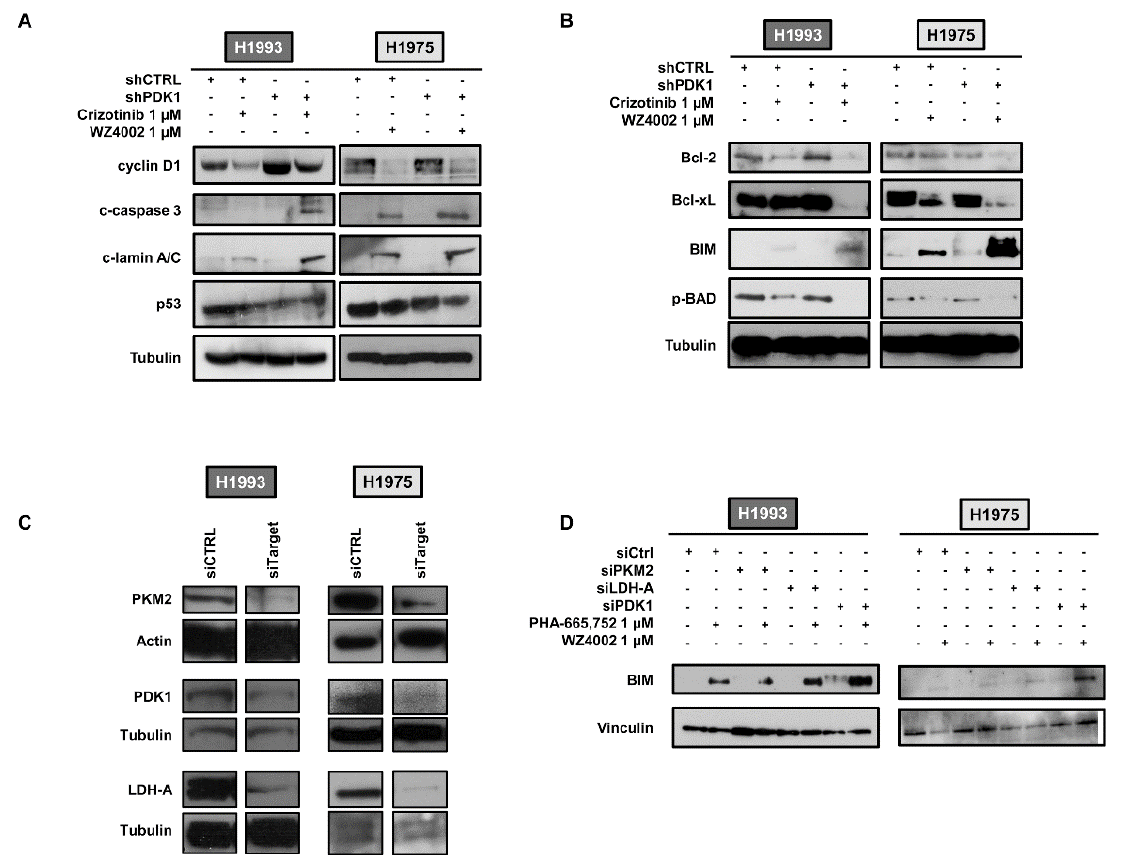
Figure 3. Combined effects of PDK1 knockdown and TKI treatment on cyclin D1, apoptotic markers and levels of Bcl-2 family members. ( A,B ) Western blot analysis of whole cell lysates from shCTRL and shPDK1 H1993 and H1975 cells in basal conditions and after treatment with crizotinib or WZ4002, respectively, showing levels of cyclin D1, cleaved caspase 3, cleaved lamin a/c and p53 ( A ) along with levels of Bcl-2 family members ( B ). ( C ) LDH-A, PKM2 or PDK1 silencing in H1993 and H1975 cells by siRNA and levels of the target protein. ( D ) Representative Western blots showing BIM levels in siRNA transfected H1993 and H1975 cells in basal conditions and after treatment with TKIs. Tubulin, actin or vinculin served to ensure equal loading. The uncropped Western Blot images can be found in Figures S8–S14.